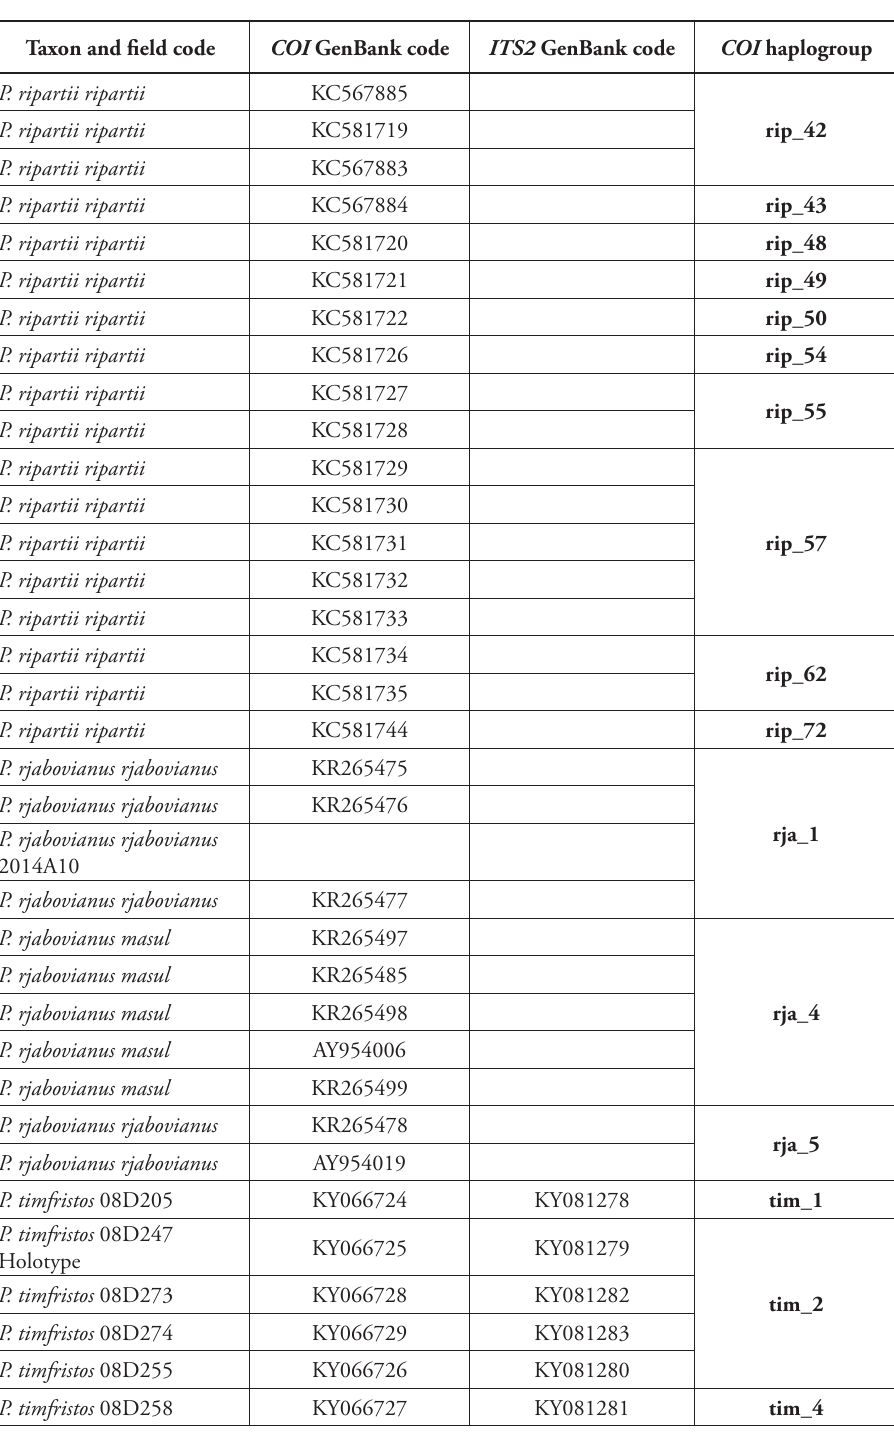
Maria S. Vishnevskaya et al. / Comparative Cytogenetics 10(5): 1–85 (2016) 16